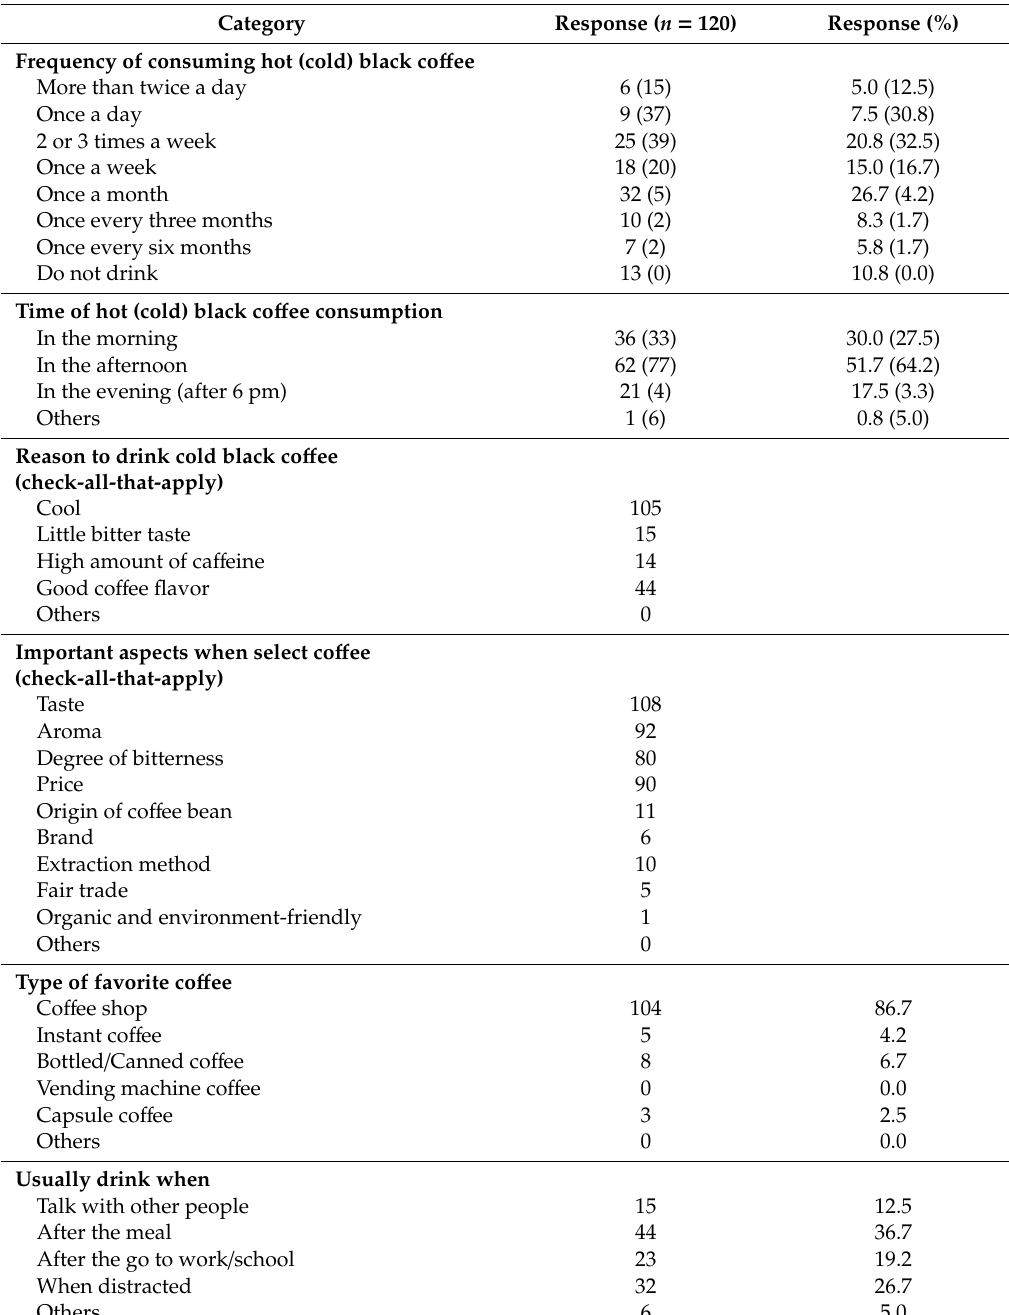
Table 2. About 76% of participants responded that they consumed cold black co ff ee more than once ◦ a week. Evaluation was conducted in August (average high 33.4 C in Busan), so there may be the possibility of seasonal influence on the frequency of cold black co ff ee consumption. Table 2. Consumers’ co ff ee consumption